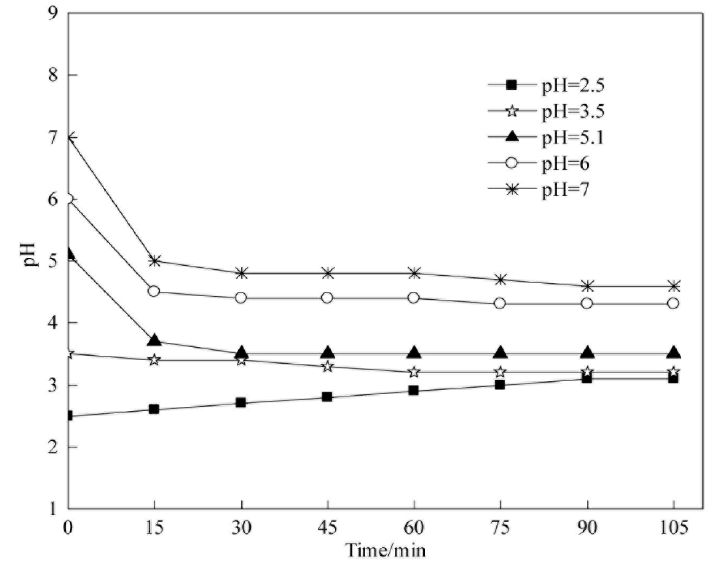
Figure 9. Changes in pH in the reaction.